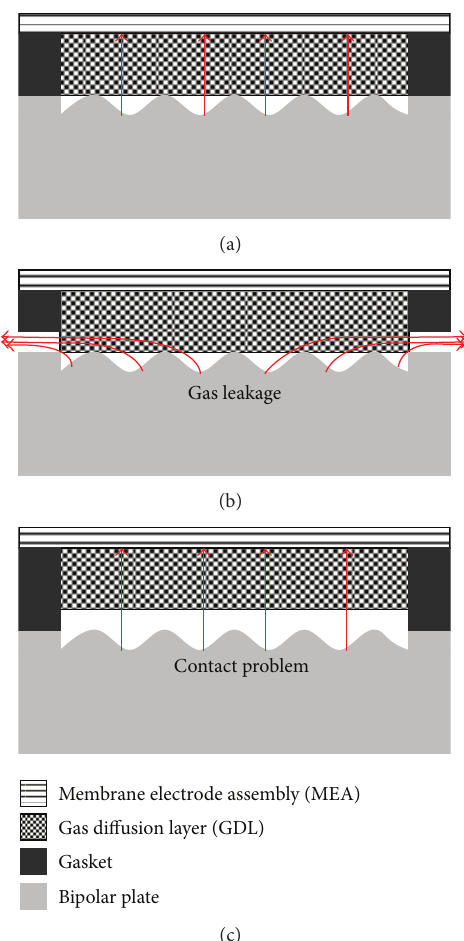
Figure 1: Schematic diagram of a half-cell configuration: (a) opti- mum, (b) with thinner gasket, and (c) with thicker